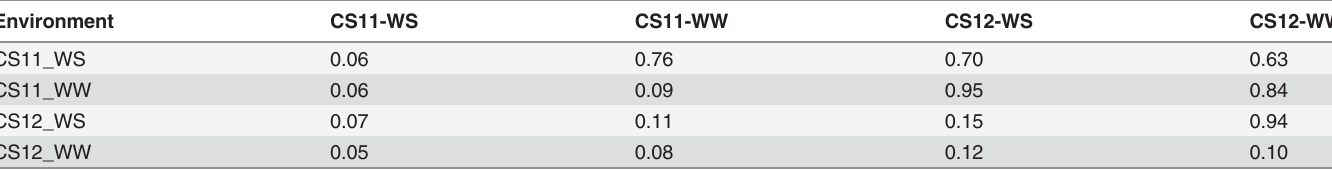
Table 4. Variance-covariance unstructured matrix for grain yield (ton/ha).